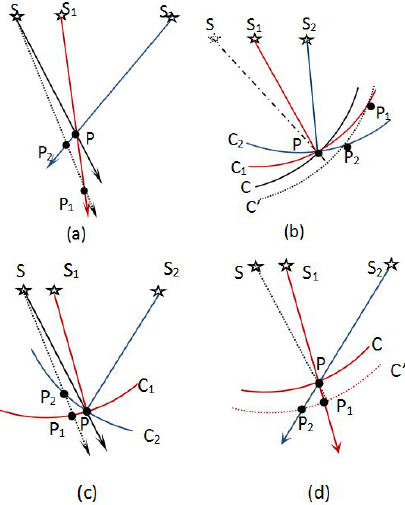
Fig2.Effect of weak convergence geometry on imagery positioning error.(a)OPT images;(b)SAR images;(c)SAR